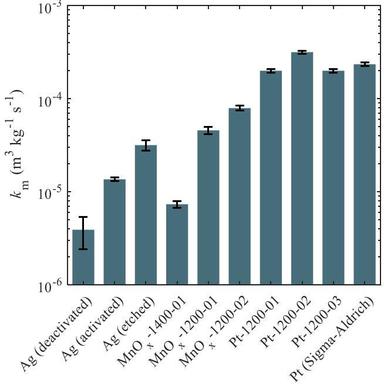
Room temperature rate constants (total mass basis) for the tested catalysts. Note the use of a log-scale on the y-axis.